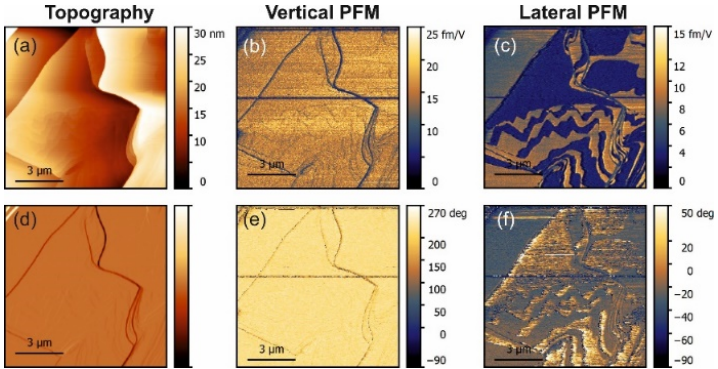
Figure 4. PFM measurements in glycine with L ‐ threonine and L ‐ alanine co ‐ doping. ( a ) Topography and ( d ) deflection; ( b ) amplitude and ( e ) phase of the vertical piezoresponse; ( c ) amplitude and ( f ) phase of the lateral piezoresponse.